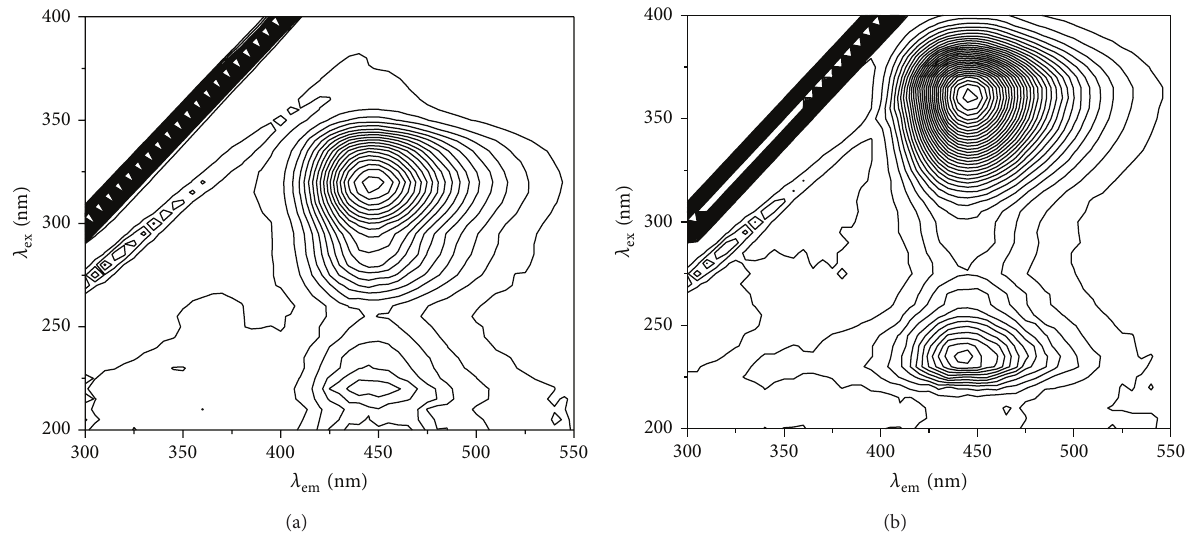
Figure 6: 3D fluorescence spectra of CDC solution at different pH. 𝑐